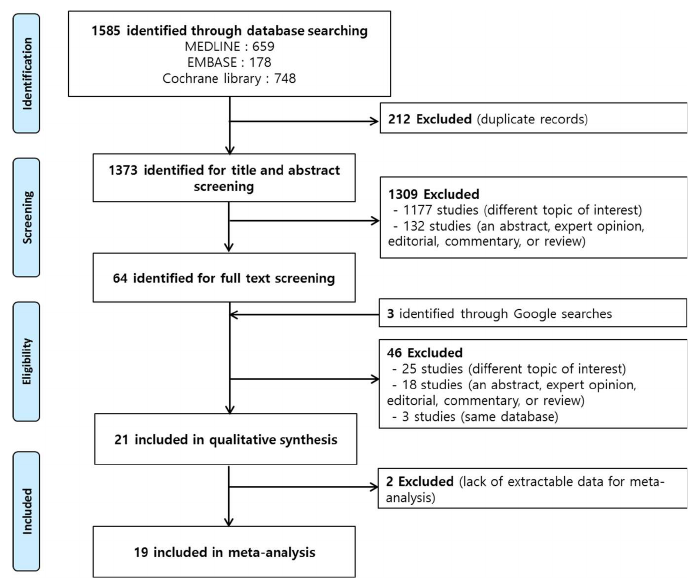
Figure 1. Schema of the search strategy.